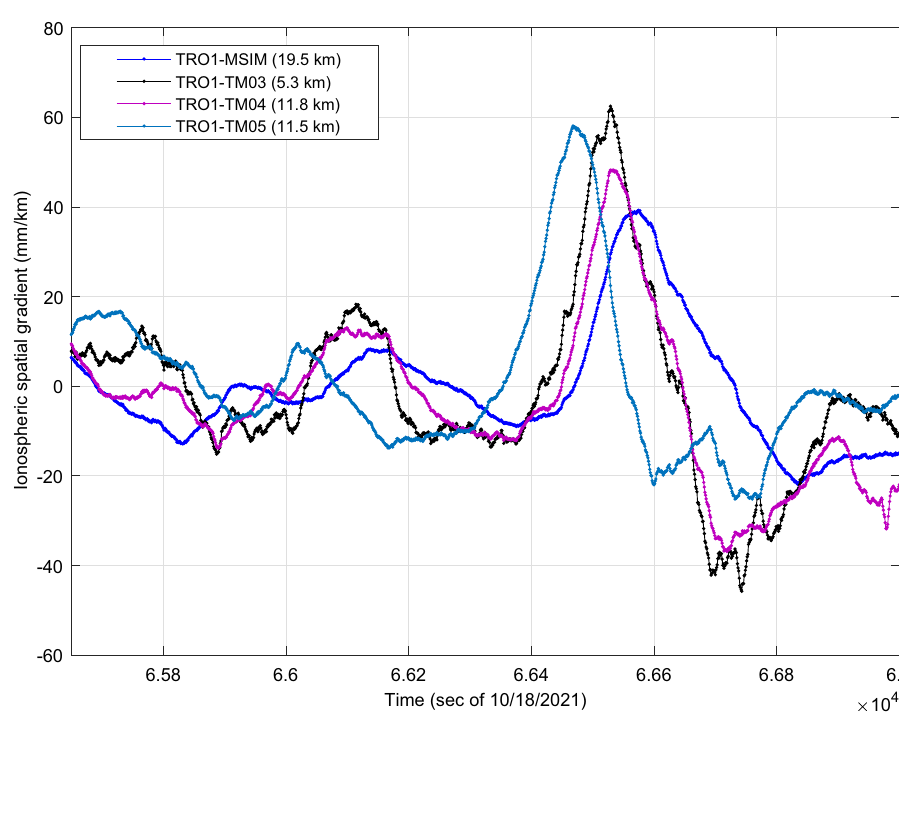
Fig. 7 95th percentile of verti- cal position noise (standard deviation) depending on the month and hour-of-day. The red line marks sunrise, while the magenta line marks sunset. For days where the lines are not present, there is either per- manent sunlight or darkness. The white dashed lines marks the